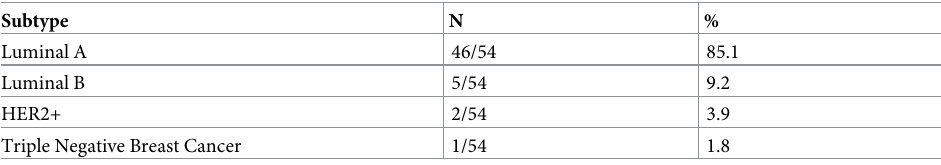
Table 2. Frequency of molecular subtypes in the study